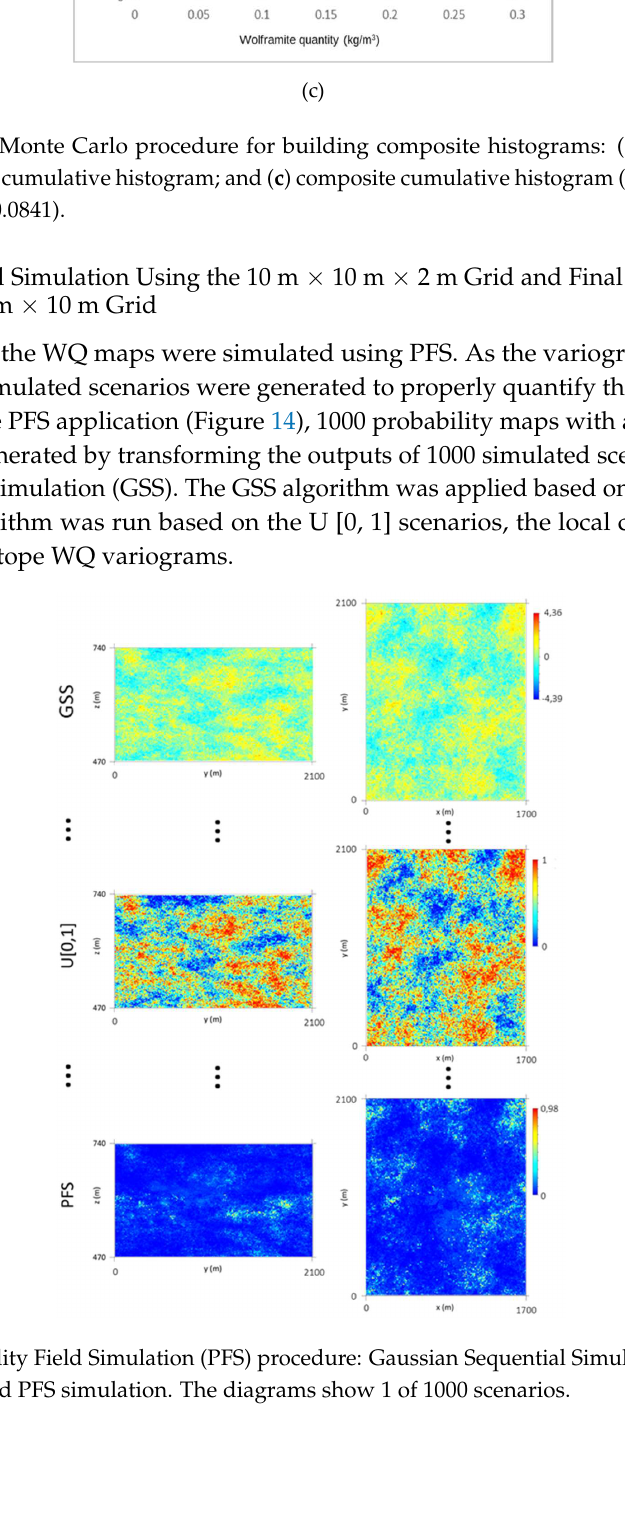
Figure 15. Results for the final model of wolframite quantity (in kg/m 3 ) (average and coefficient of variation): Px81 (left) and Pz75 (right).